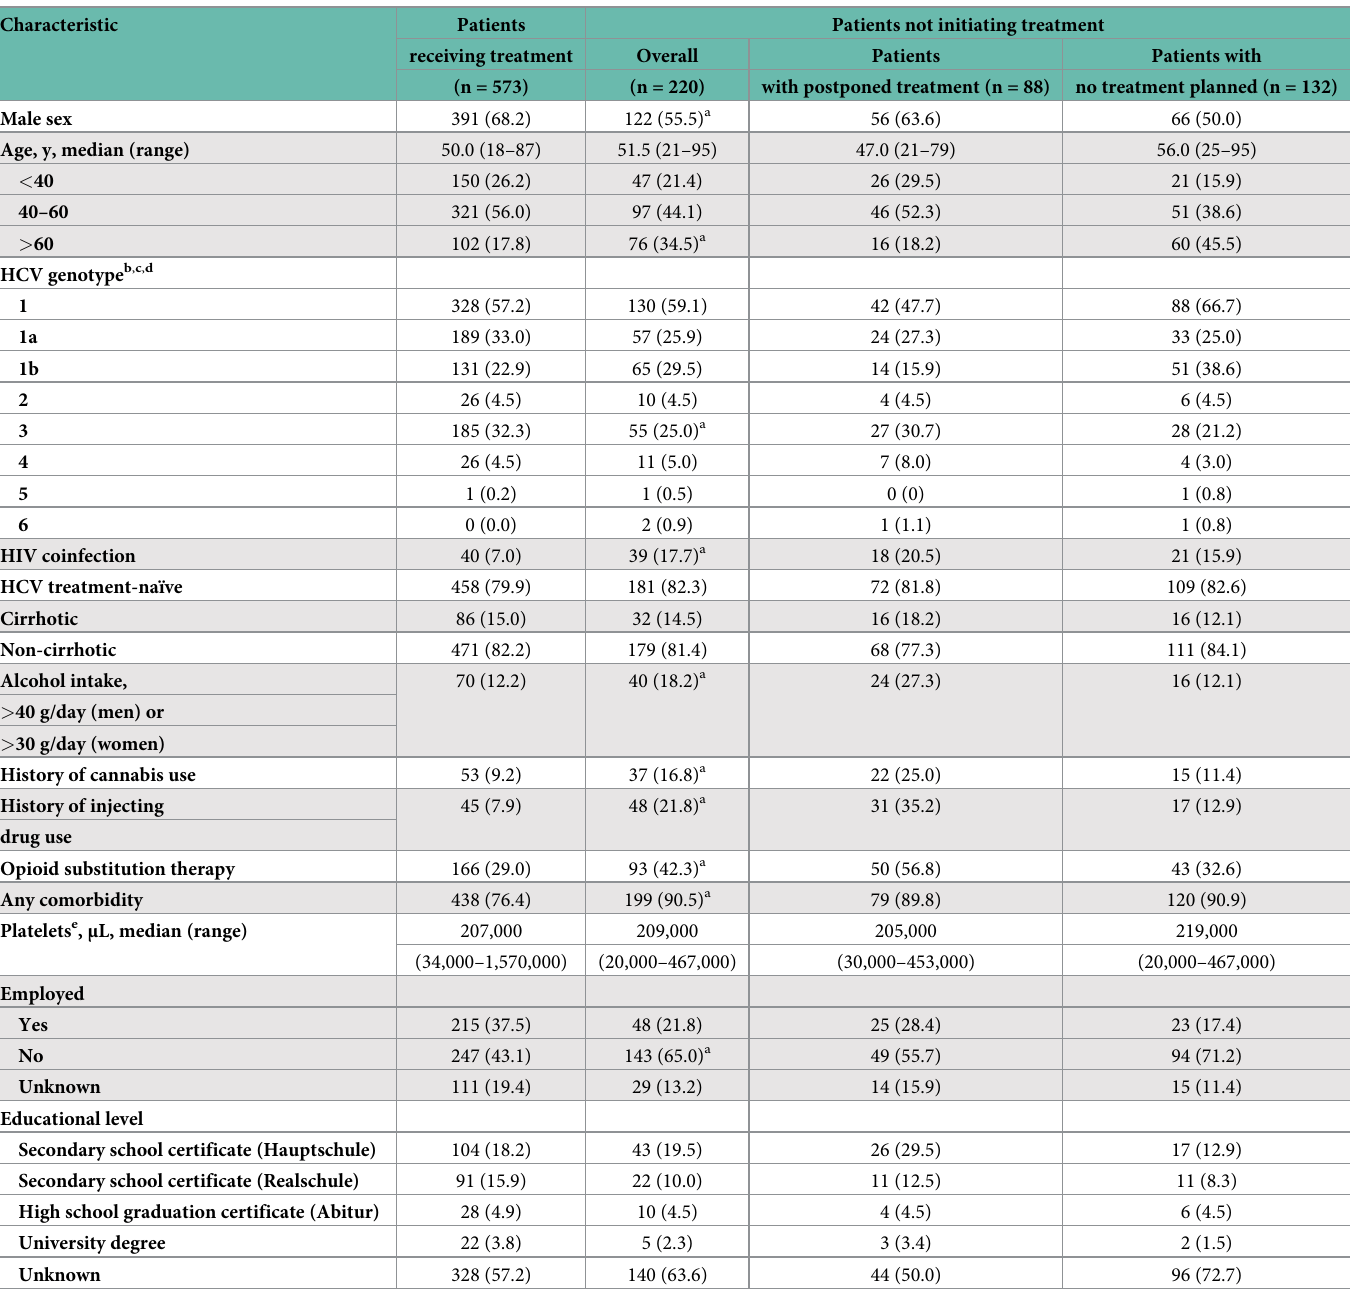
Table 1. Clinical characteristics and demographics in patients with CHC